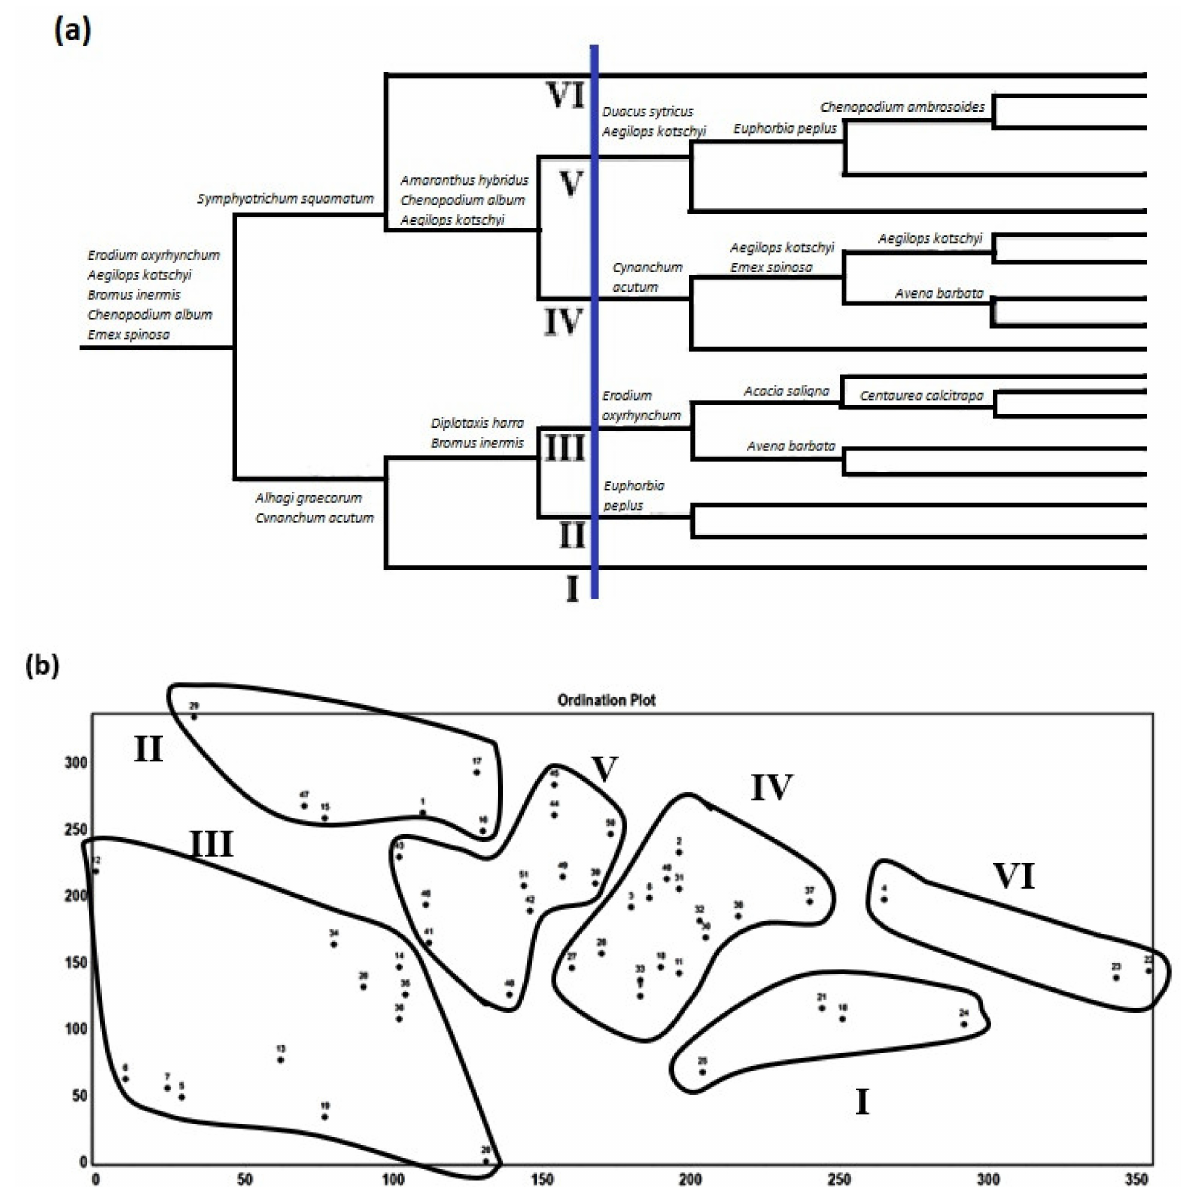
Figure 5. Dendrogram of the 6 vegetation groups derived after application of TWINSPAN classification technique ( a ), cluster segregation of the 6 vegetation groups along axes 1 and 2 using DECORANA ( b ). The 6 groups are named after characteristic species as follows: I: Urospermum picroides , II: Chenopodium murale , III: Malva parviflora , IV: Cynodon dactylon , V: Hordeum leporinum , and VI: Sonchus oleraceus